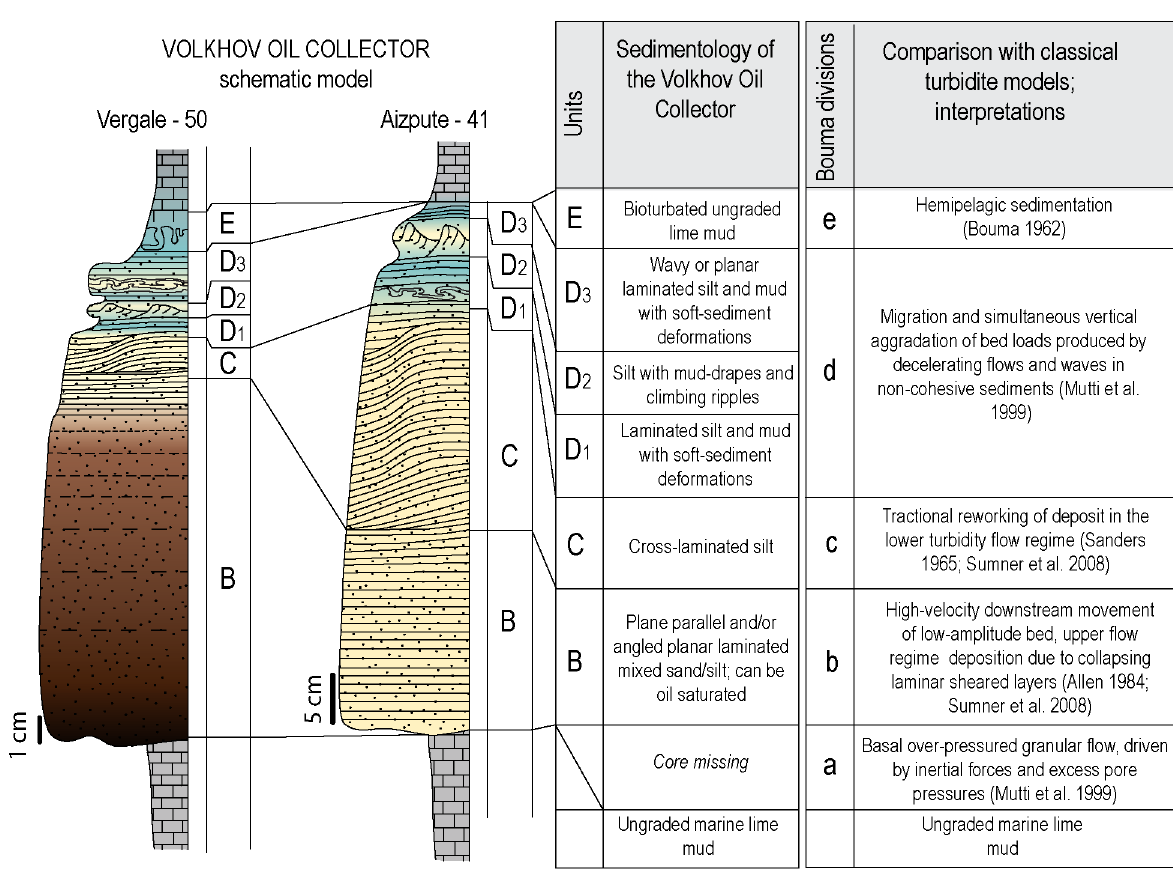
Fig. 7. Schematic cross sections of the Volkhov Oil Collector bed in the Vergale-50 and Aizpute-41 drill cores. The sedimentary textures are compared with the classical turbidite model by Bouma